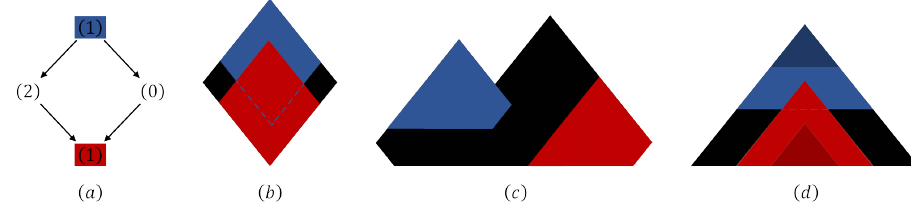
Figure 12: Some examples of self-symmetric